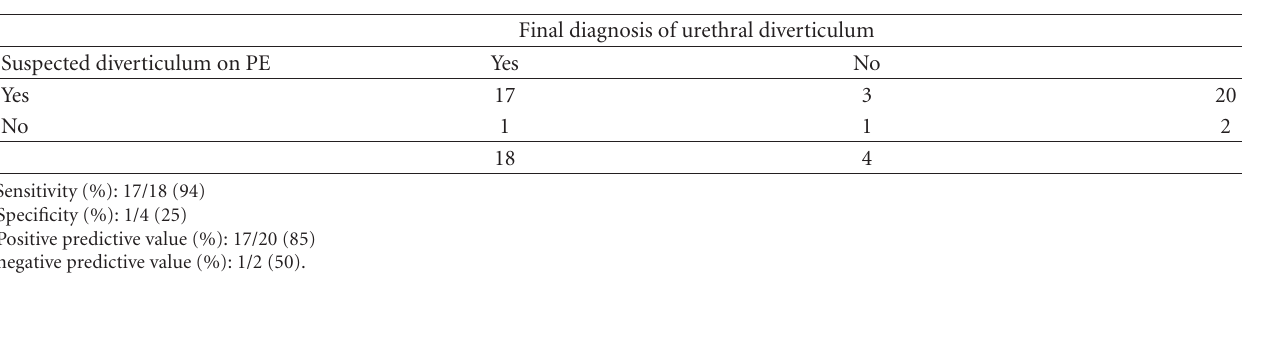
Table 2: Physical exam (PE) findings in 24 patients with definitive diagnosis. Definitive diagnosis was made by either surgery or imaging